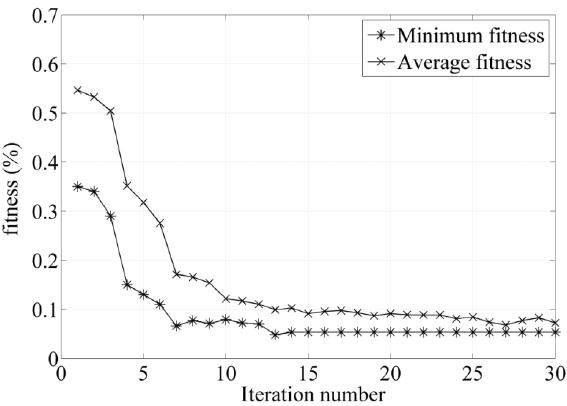
Figure 6 ． Variation of fitness value with iteration numbers.